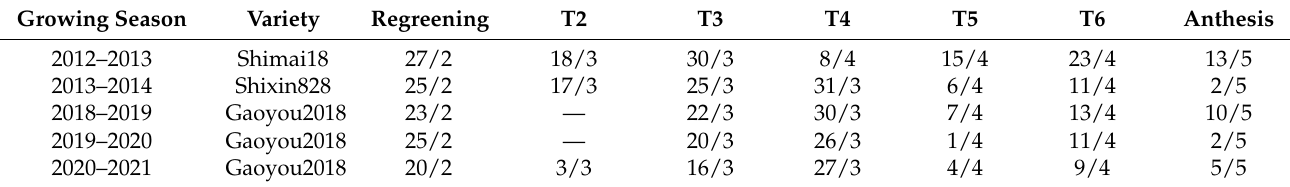
Table 1. Date of irrigation and topdressing of different treatments in each growing season.